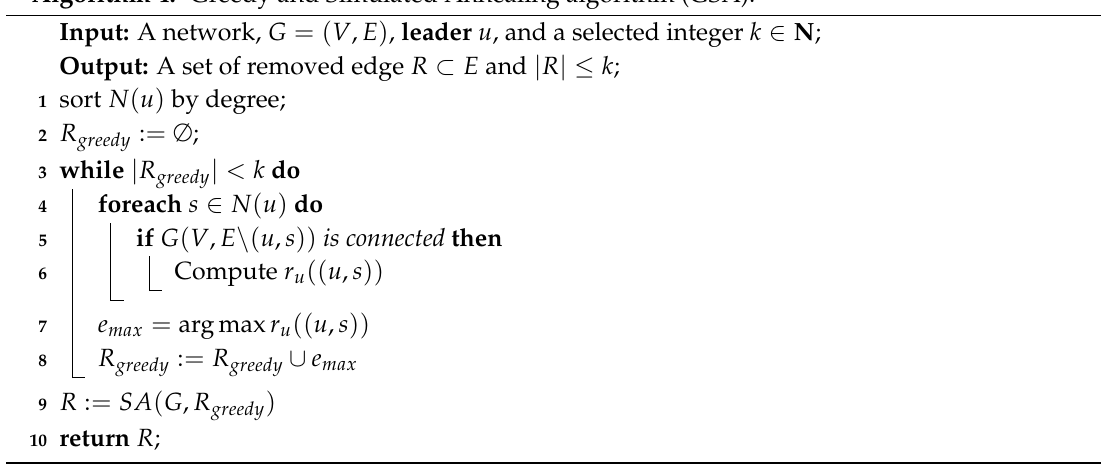
Algorithm 4: Greedy and Simulated Annealing algorithm (GSA).